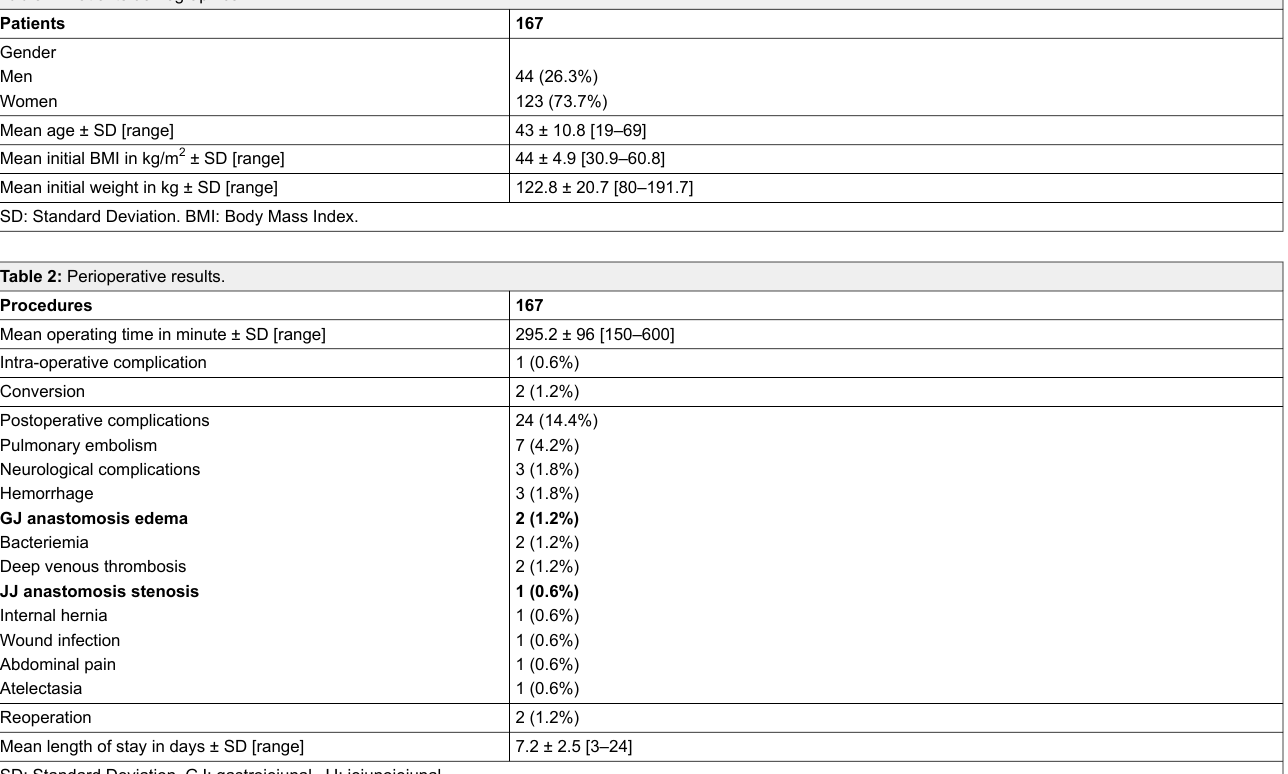
Table 1: Patients demographics. Patients